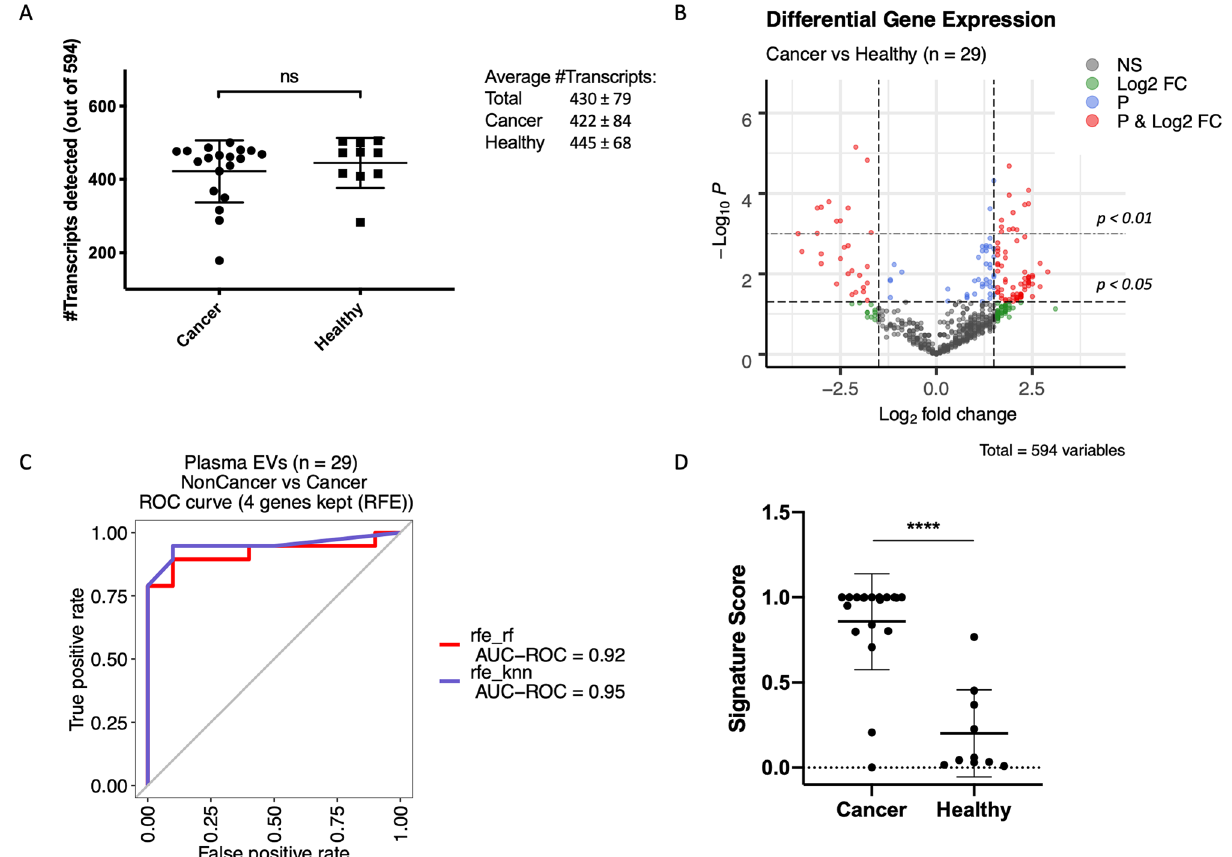
Figure 3. EV-mRNA transcript detection, differential expression analysis and development of a classifier algorithm. ( A ) Number of transcripts detected in EVs from cancer patients and healthy controls using the Human Immunology v2 nCounter panel, which targets 594 genes (two-tailed Mann–Whitney U test, p = 0.463 ). ( B ) Differential expression analysis of log2-normalized counts between cancer patients and healthy controls. The full list of genes differentially expressed is presented in Supplementary Table S1. ( C ) Area under the ROC curve of the four-gene signature, selected using recursive feature elimination (RFE), to differentiate cancer from control samples. ( D ) Scores of cancer versus control samples based on expression of the four-gene signature ( p < 0.001 in a two-tailed Mann–Whitney U test). NS, not significant; EVs, extracellular vesicles; ROC, receiver operating characteristic; AUC, area under the curve; RFE, recursive feature elimination; rf, random forest; knn, k-nearest ples decreased from 430 ± 79 to 115 ± 66 and the total counts dropped more than 90%. As previously observed in samples without DNase treatment, the number of transcripts detected in cancer versus control samples were not significantly different (122 ± 77 vs 103 ± 39, Mann–Whitney’s U p = 0.92 , Fig. 4b). In addition, there were no significant differences in the number of transcripts detected between the different tumor types; which included